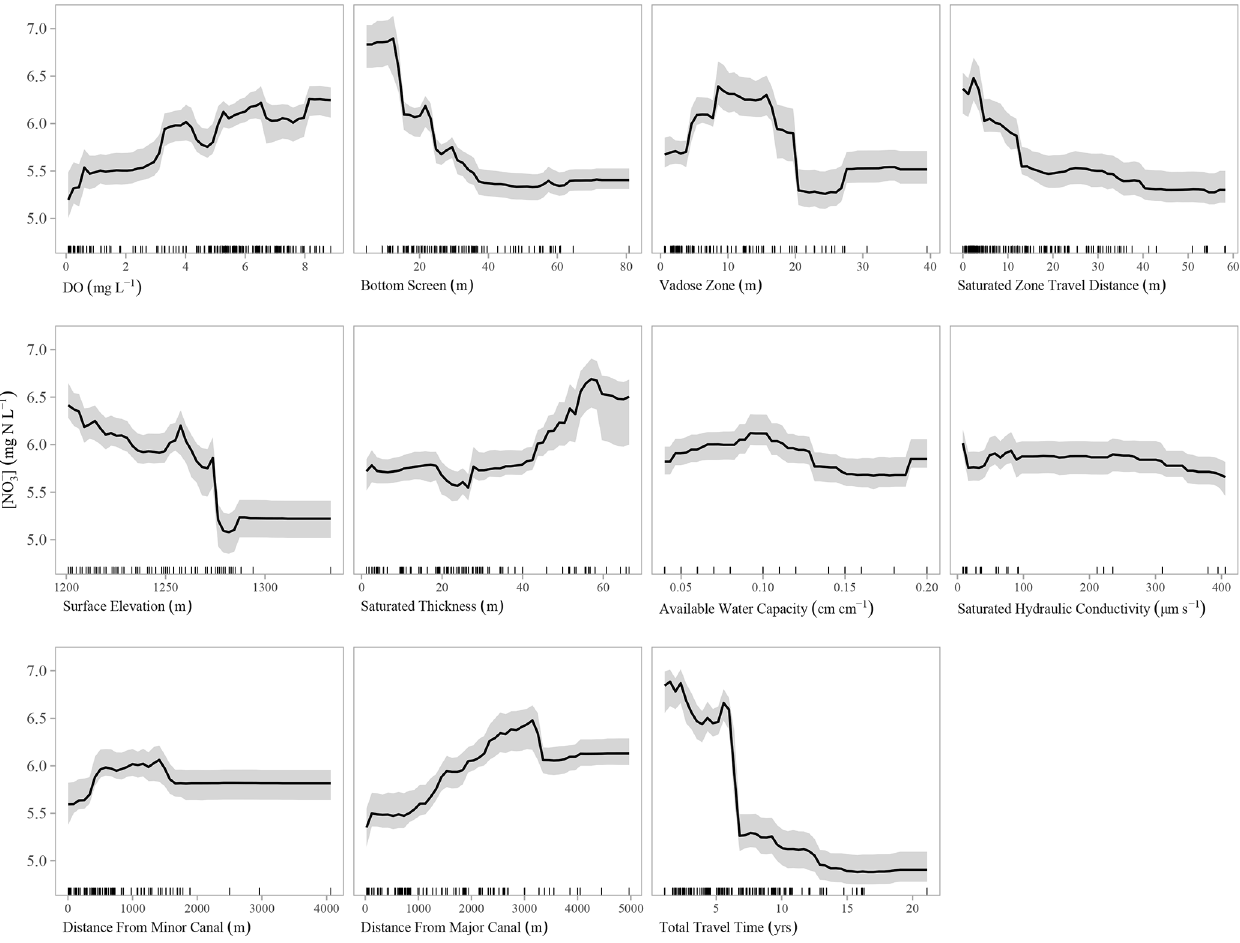
Figure 8. Partial dependence plot for the model evaluating the transport rate combination of V u = 3 . 5myr − 1 and V s = 3 . 75myr − 1 . Tick marks on each plot represent predictor observations used to train